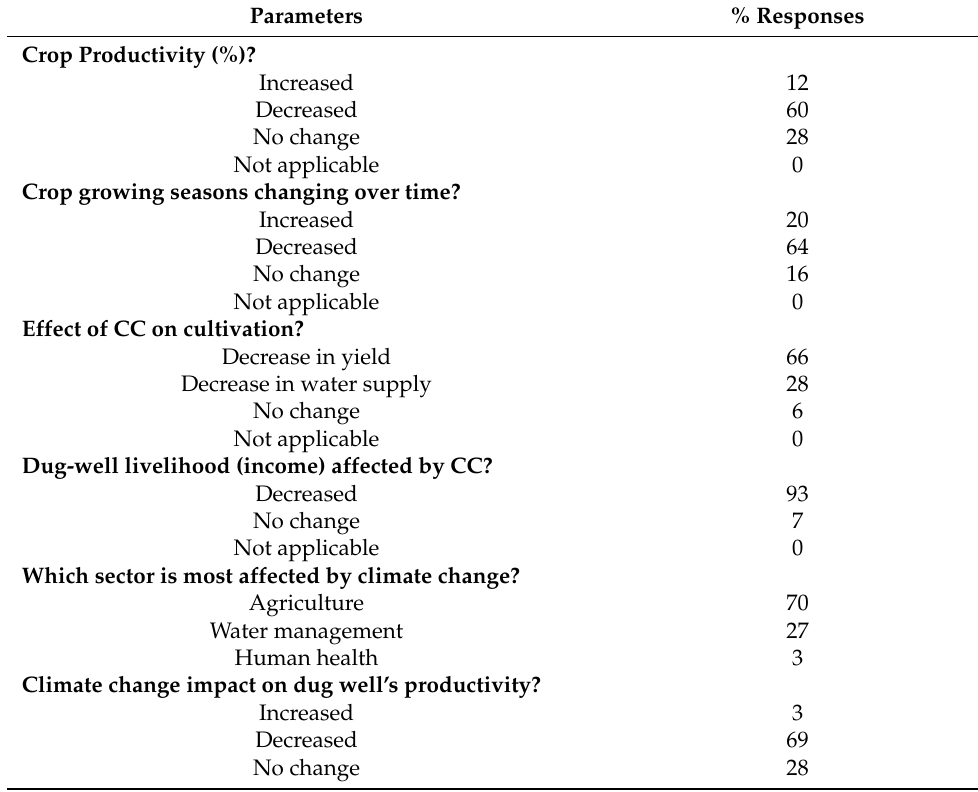
Table 9. Perception about climate change’s impact on agriculture. Parameters %